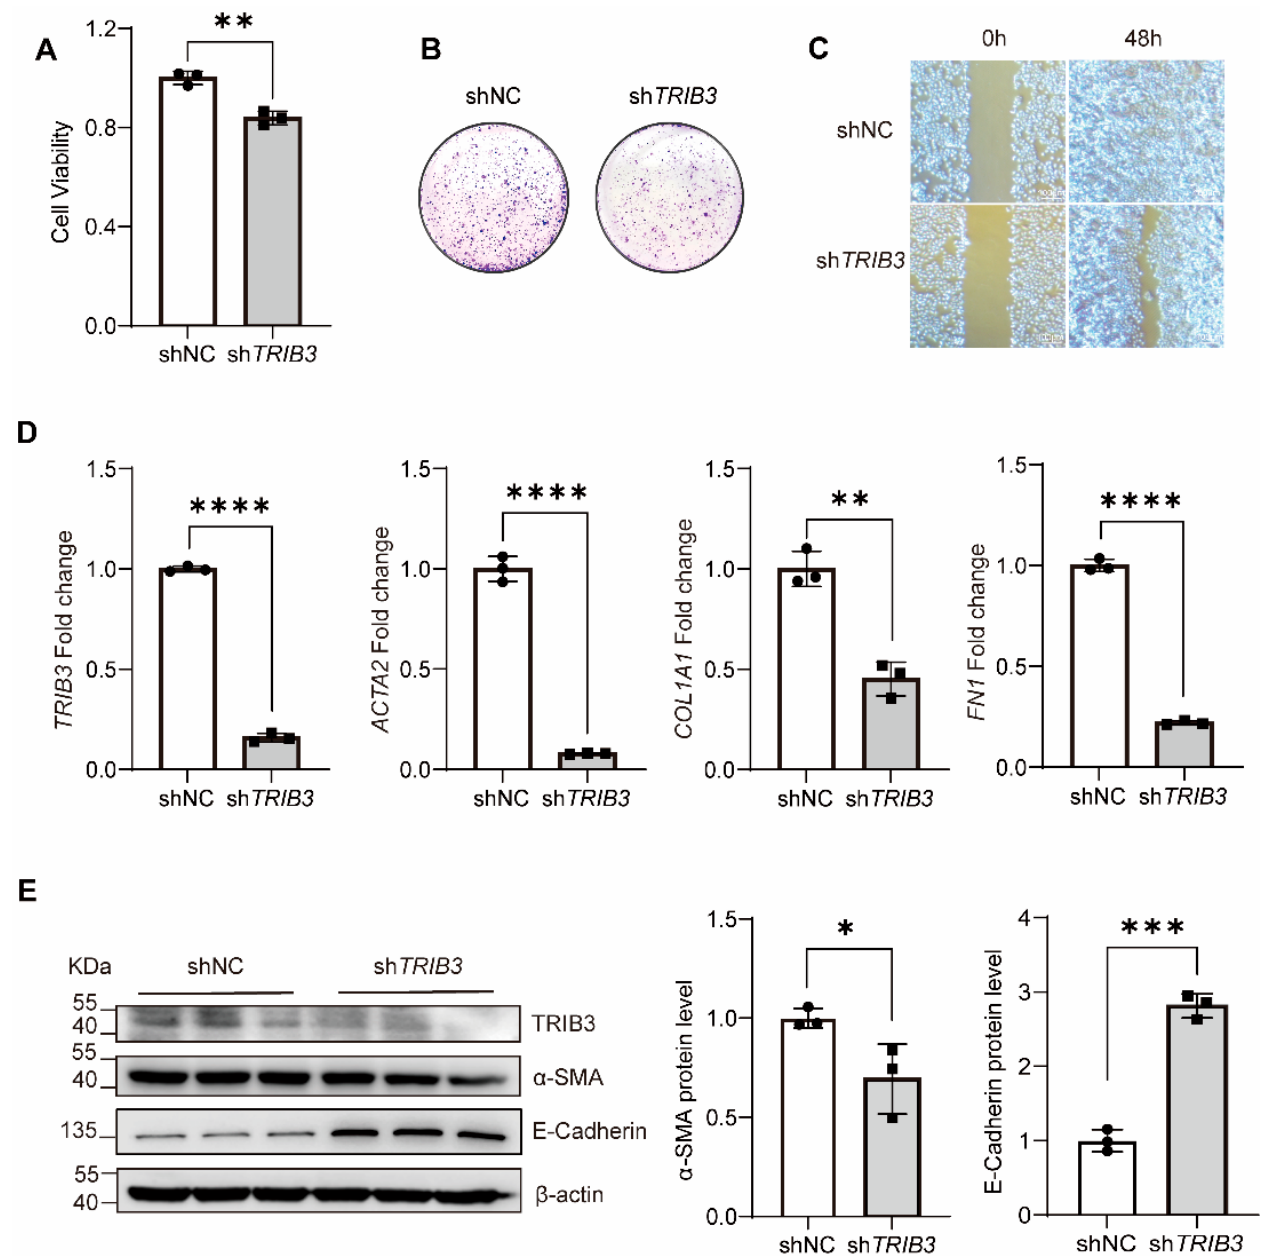
Figure 2. TRIB3 deficiency inhibited A549 cell proliferation, migration, and profibrotic gene expres- sions. A. The effect of TRIB3 silencing on the viability of A549 cells was assessed by CCK8 assay.